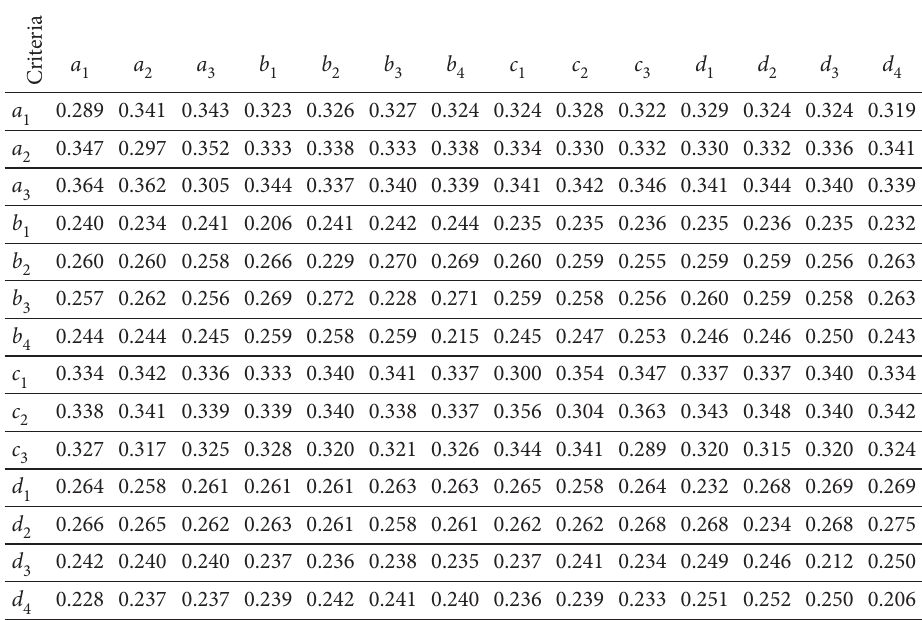
Table 6. Un-weighted super-matrix W based on DANP for financial center modernization